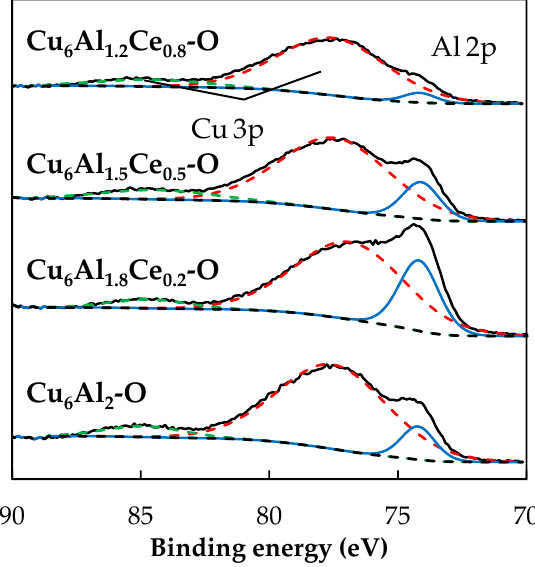
Table 3. Summarized XPS results from Ce 3d, O 1s spectra and atomic ratios.